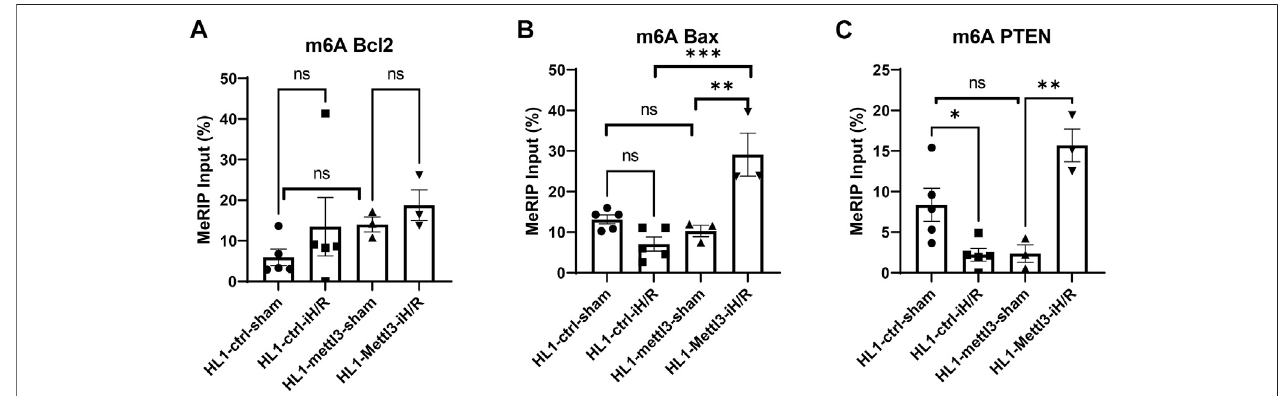
FIGURE 5 | In vitro hypoxia/reperfusion (iH/R) stress regulates m6A levels of key anti-apoptotic and pro-apoptotic genes. ( A – C ). Ctrl and Mettl3 mo fifi ed HL1 cardiomyocytes were subjected to sham or iH/R, and total RNA was subjected to m6A RIP, followed by RT-qPCR using primers for the indicated pro-apoptotic genes (Bax and PTEN) and anti-apoptitic gene (Bcl2). Values are normalized to input. n (cid:1) 3 – 5, * p < 0.05; ** p < 0.01; *** p <